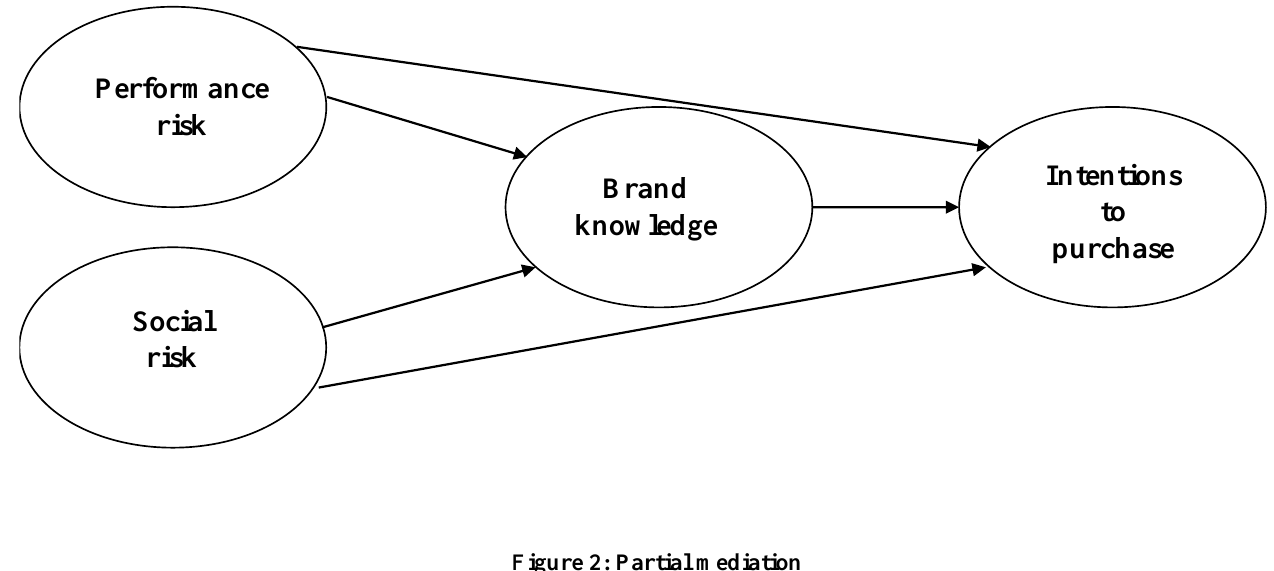
Figure 2: Partial mediation Table 3: Brand knowledge as intervening variable: Full